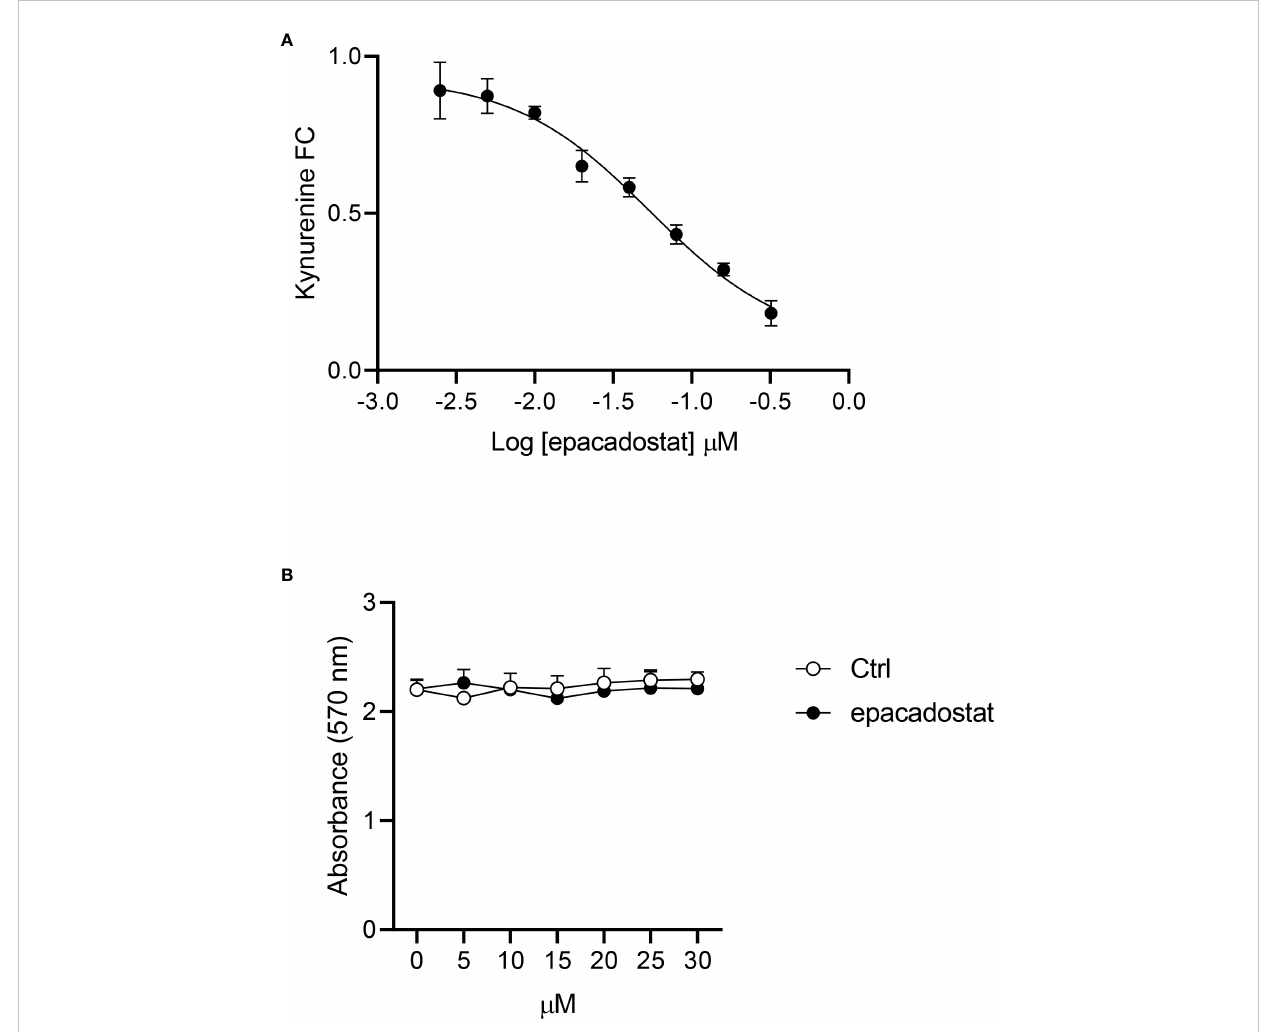
FIGURE 1 Epacadostat inhibits the IDO1 enzymatic activity in P1 tumor cells. (A) Dose – response curve of epacadostat used to calculate the IC 50 value in P1.IDO1 cells. Results are the mean ± SD of the kynurenine fold change (FC) of three independent experiments, each performed in triplicate. (B) Cell viability percentage (%) of P1.IDO1 cells treated with epacadostat or the vehicle alone as a control (Ctrl). Results are the mean ± SD of three experiments, each conducted in